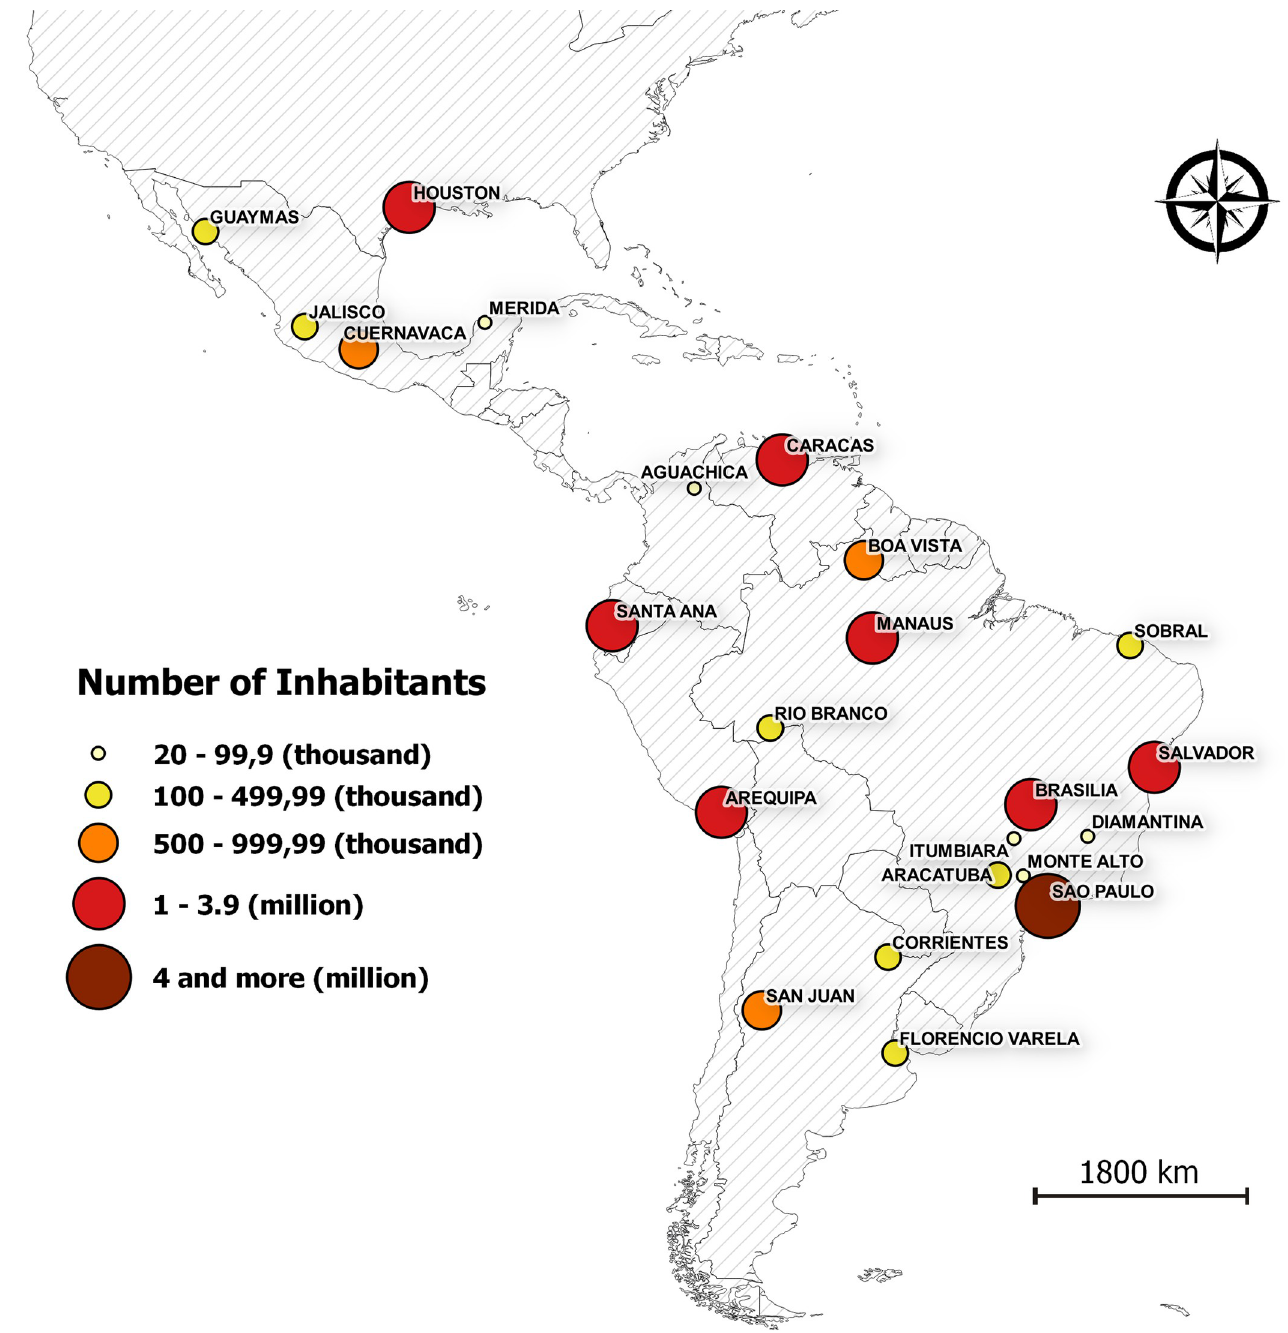
Fig 4. Urban agglomerates where urban vectors with their respective population density have been reported. Number of inhabitants according to Comisión Económica para América Latina y el Caribe CEPAL (2009) [30]. Map was generated using the free open source geographic information system software QGIS Girona 3.0 free access program (QGIS Development Team 2018, https://www.qgis.org/es/site/); the shape file of the Neotropical countries outlines are freely available at http://www.efrainmaps.es (Carlos Efraı´n Porto Tapique´n. Geografı´a, SIG y Cartografı´a Digital. Valencia, Espa ñ a, 2020).